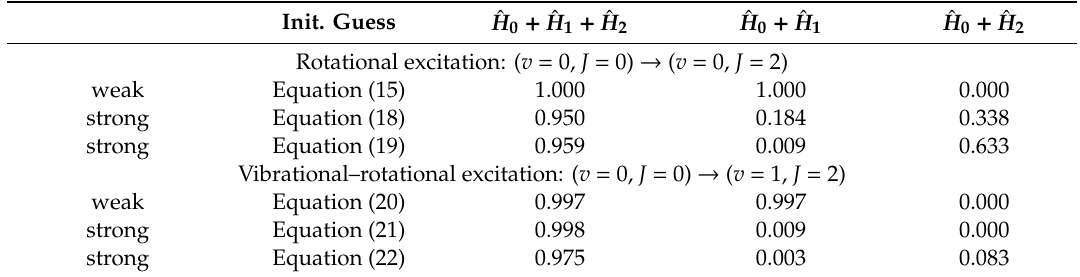
Figure 3. ( a ) The optimal field ε ( t ) obtained with the initial guess, Equation (18), for the rotational excitation, ( v = 0, J = 0) → ( v = 0, J = 2), in the strong-field regime; ( b ) the spectrum of ε ( t ).